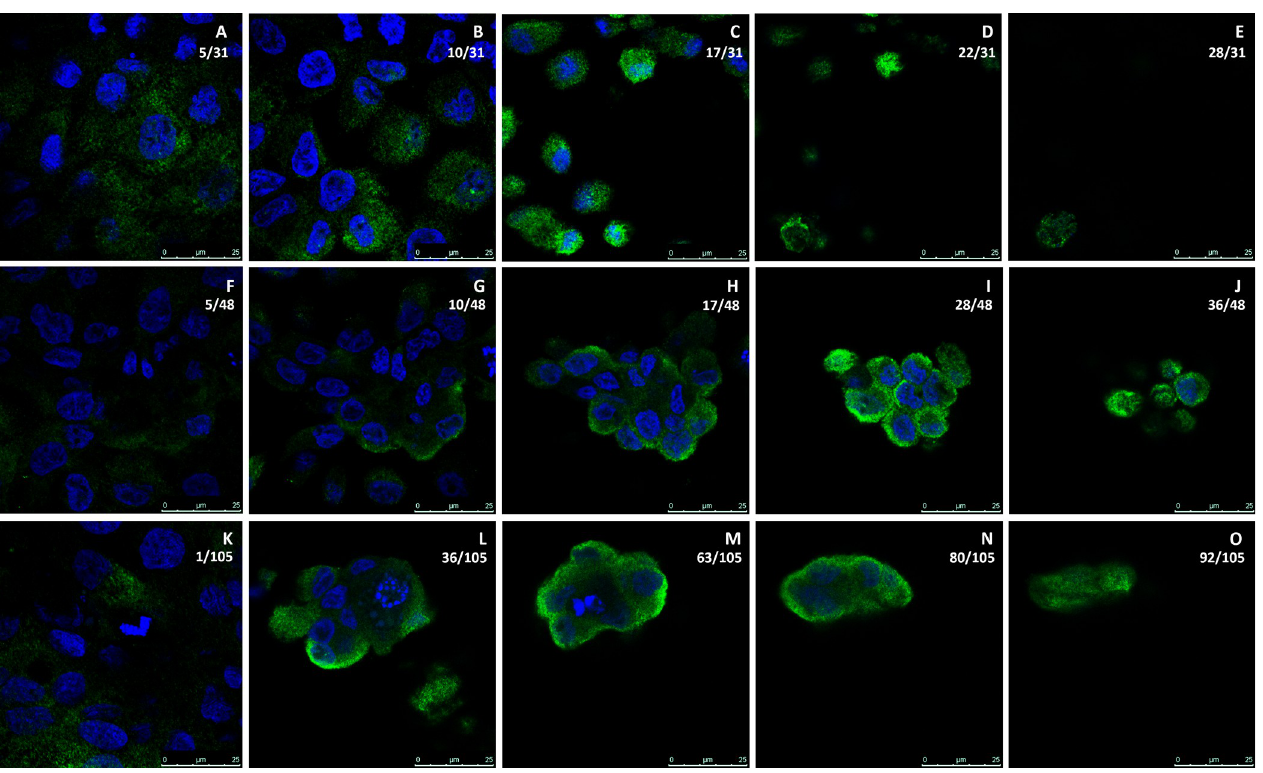
Fig 2. Intracellular localization of MT-3 in a doming population of HK-2(MT-3) cells. MT-3 (green) is seen in a non-doming monolayer (A-E), a moderately tall dome (F-J), and in a taller dome structure (K-O). Nuclei are stained with DAPI (blue). The z-section level (0.35 μ m depth) relative to the total number of z-sections through that region is indicated as a ratio in the upper right corner of each image. The scale bar at the bottom right of each image shows increments of 5 μ m up to 25 μ m. https://doi.org/10.1371/journal.pone.0267599.g002 same 3-D analysis as for MT-3 localization, F-actin was confirmed to be exhibit heavy staining at the basal and lateral aspects of the plasma membrane (S4A, S4E and S4I Fig), and little to no F-actin was present on the apical surface so that the top-down view of the domes gave little